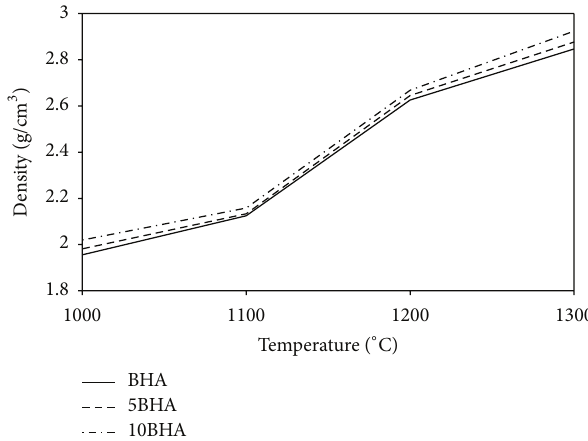
Figure 4: Variation of density of sintered BHA, 5BHA, and 10BHA composites at different sintering temperature.